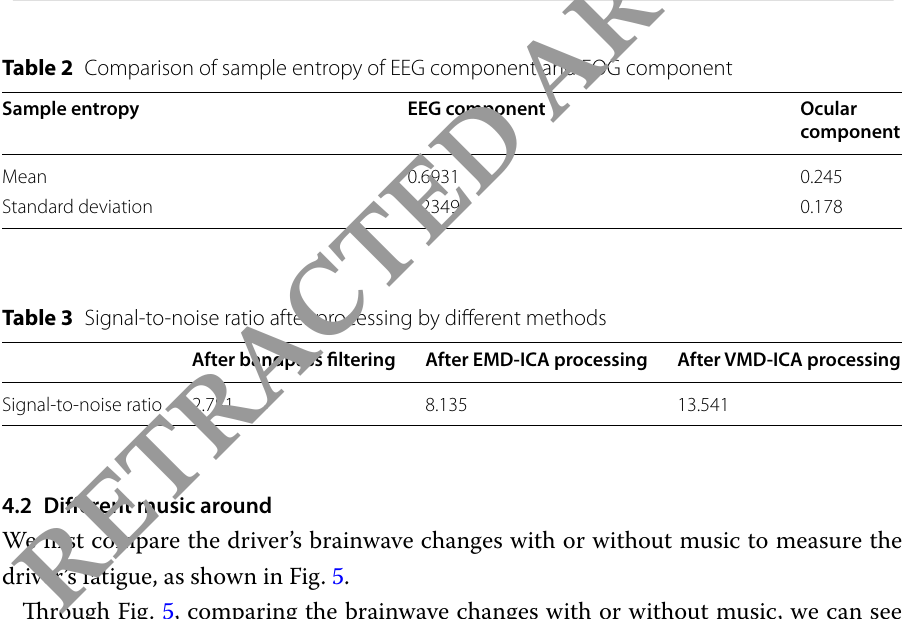
Fig. 4 Simulated driving brain wave amplitude